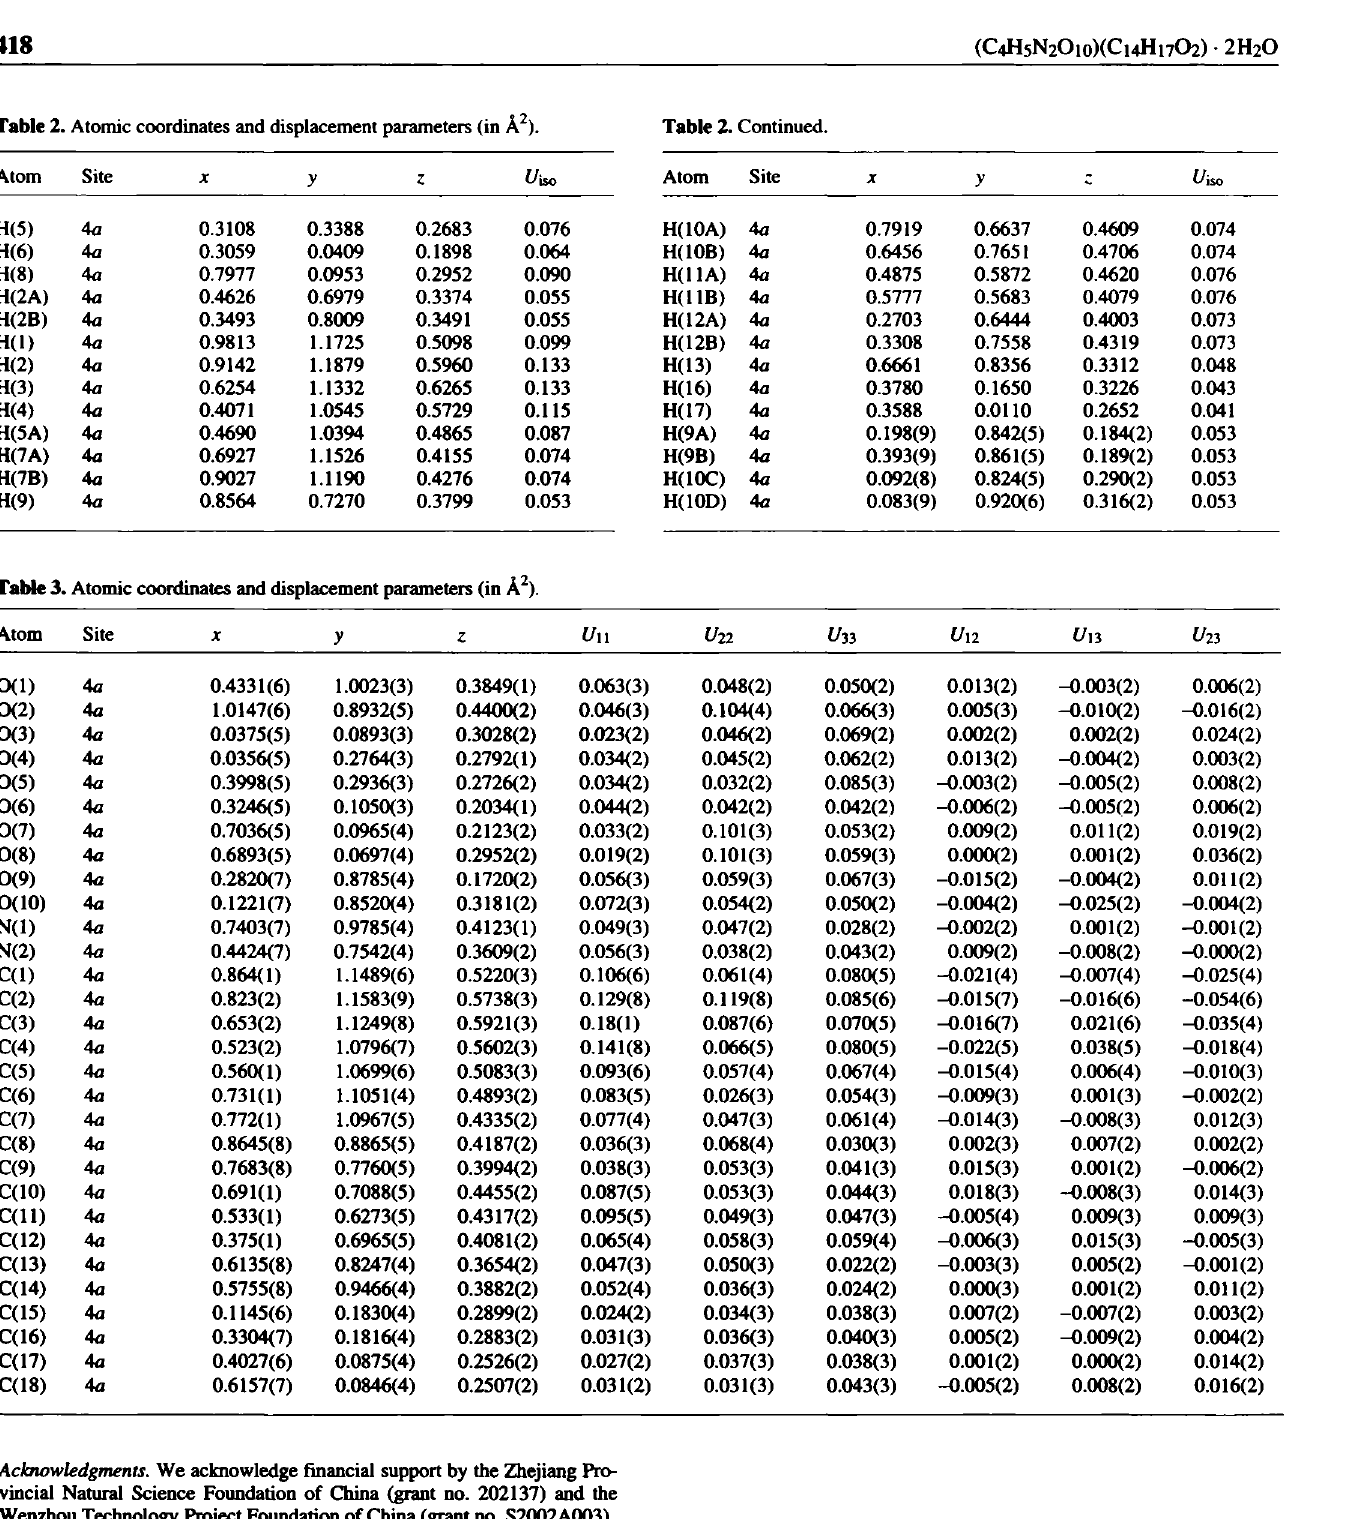
Table 2. Atomic coordinates and displacement parameters (in A 2 ).